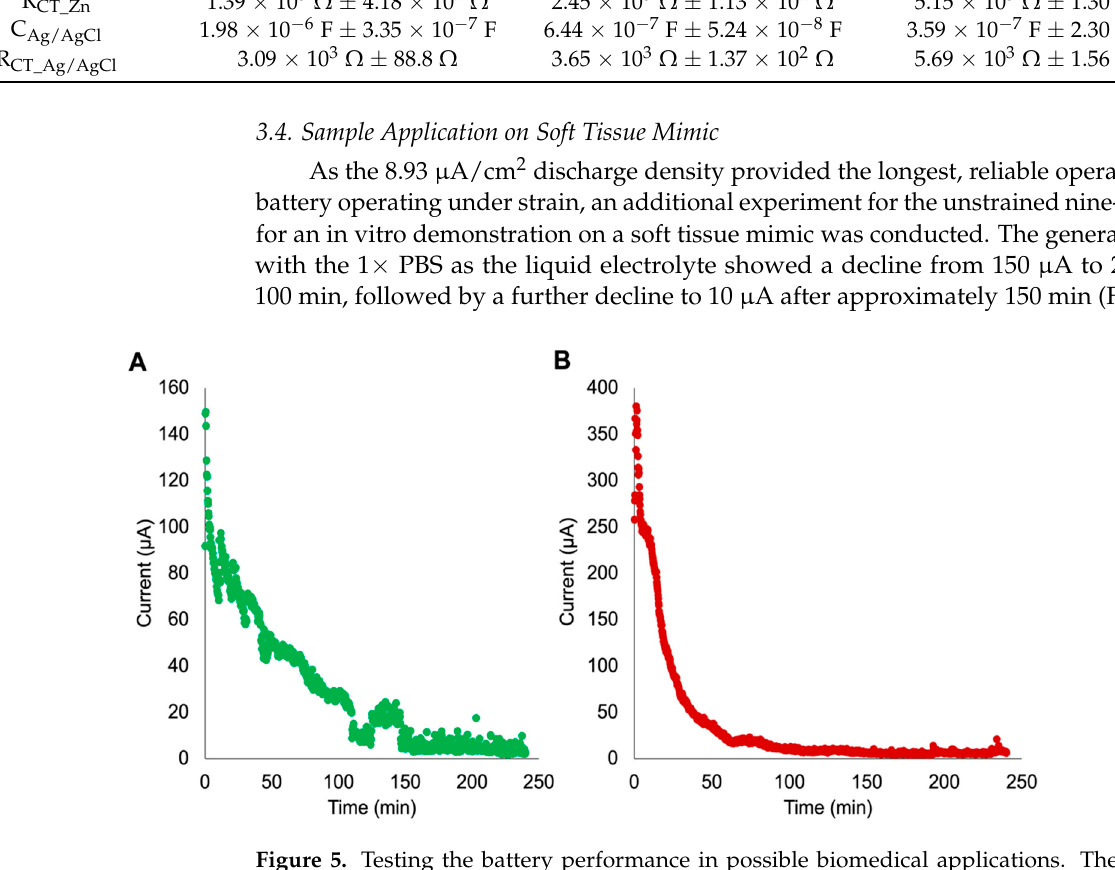
Figure 5. Testing the battery performance in possible biomedical applications. The plots show cur- rent-time measurement for the ( A ) 1× PBS electrolyte, ( B ) Gel